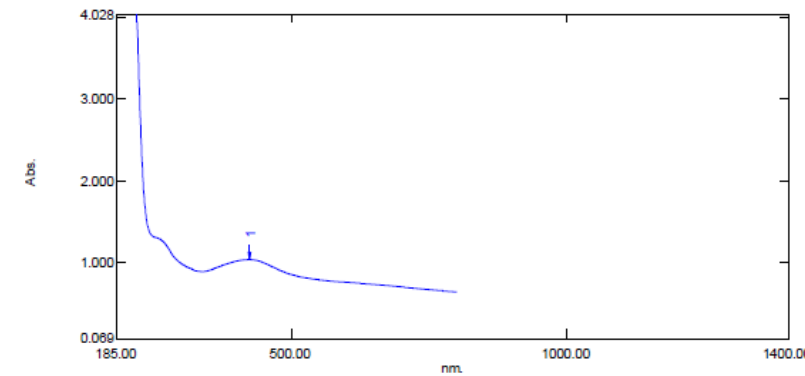
Fig. 3. UV – Vis spectroscopy of biosynthetic silver nanoparticles showing peak at 424 nm